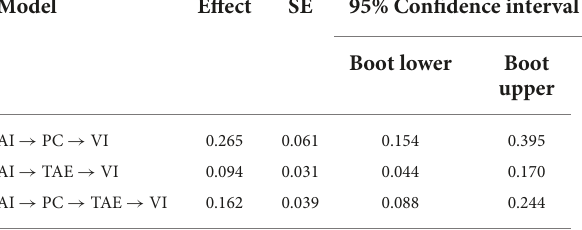
TABLE 4 Regression coefficients of serial mediation models using